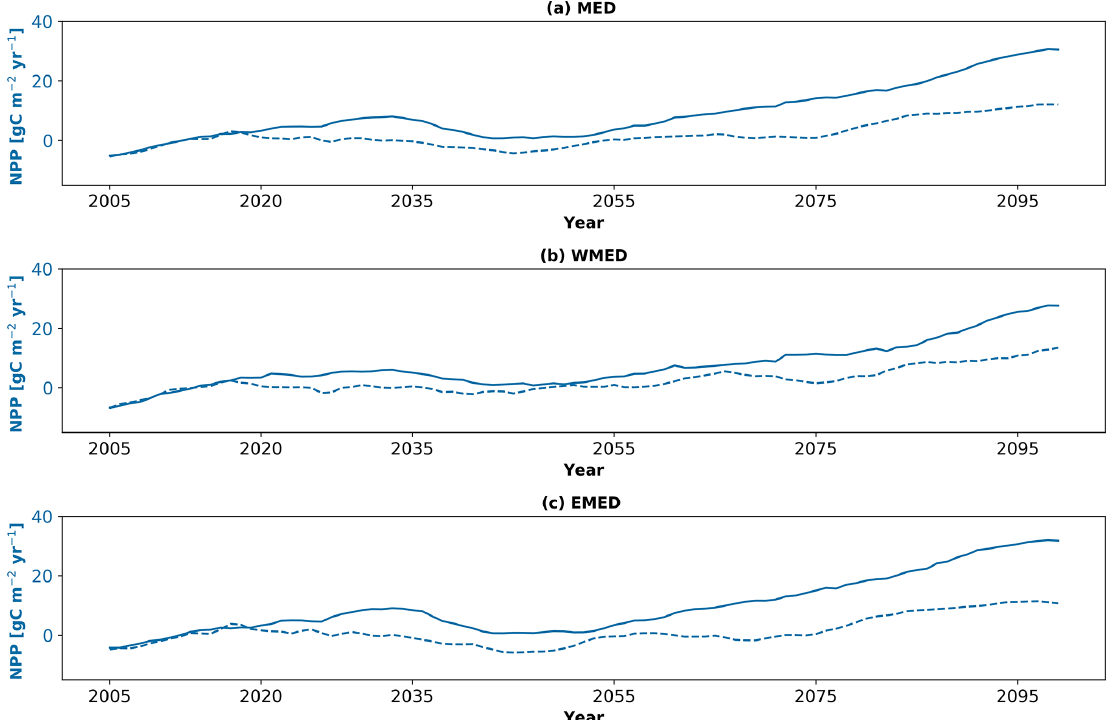
Figure 10. Yearly time series for the period 2005–2099 of integrated net primary production (blue, in gCm − 2 yr − 1 ) anomalies for the emission scenarios RCP8.5 (solid lines) and RCP4.5 (dashed lines) in the Mediterranean Sea (MED, a ), Western Mediterranean (WMED, b ) and Eastern Mediterranean (c) for the first 200m. The yearly time series have been smoothed using the 10-year running